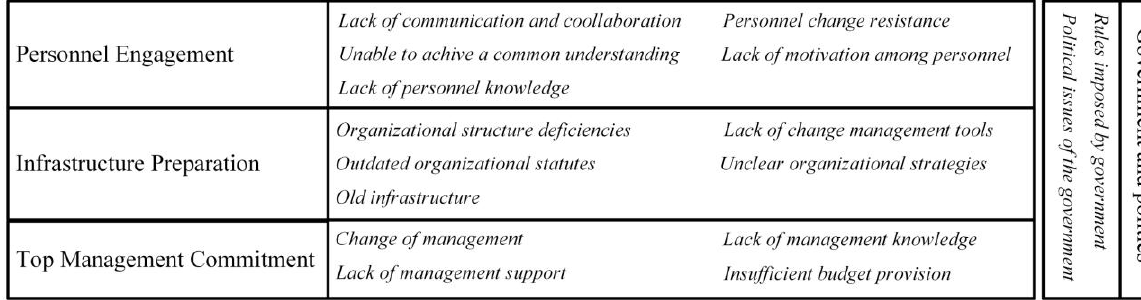
Figure 3 . Providing a higher level of abstraction for the identified obstacles